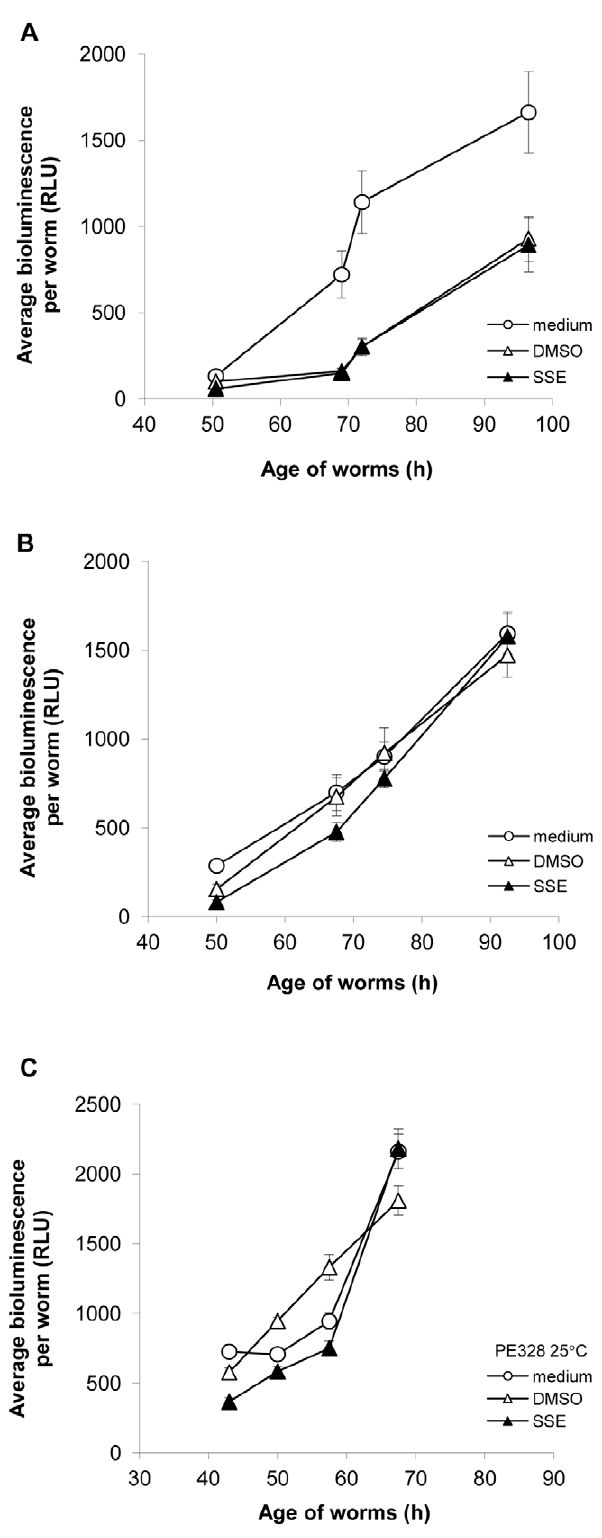
Figure 2. SSE and DMSO exposure at L1 larval stage delayed increase in bioluminescence in PE254 but not ts sterile strain PE328. SSE (1%) or DMSO (1%) was added to: (A) synchronized L1 larval stage, or (B) L4 larval stage (46–47 h) liquid cultures of strain PE254 or (C) synchronized L1 larval stage liquid culture of ts sterile strain PE328. Bioluminescence was determined over